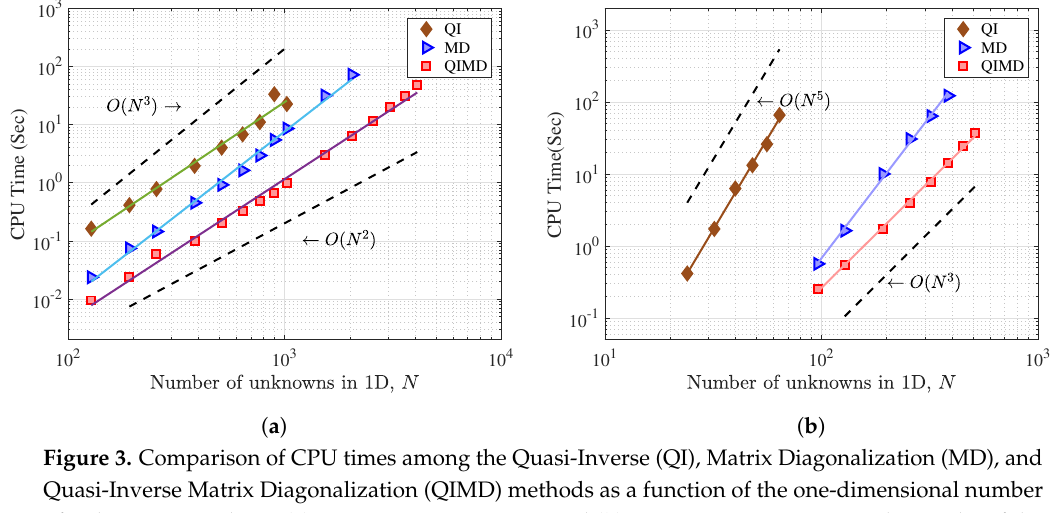
Figure 3. Comparison of CPU times among the Quasi-Inverse (QI), Matrix Diagonalization (MD), and Quasi-Inverse Matrix Diagonalization (QIMD) methods as a function of the one-dimensional number of unknowns in solving ( a ) a 2-D Poisson equation and ( b ) a 3-D Poisson equation. The results of the best linear regression associated with the lines in the figure are represented in Table 2. Here, O ( N 2 ) and O ( N 3 ) operation lines in ( a ), and O ( N 3 ) and O ( N 5 ) operation lines in ( b ) are plotted for